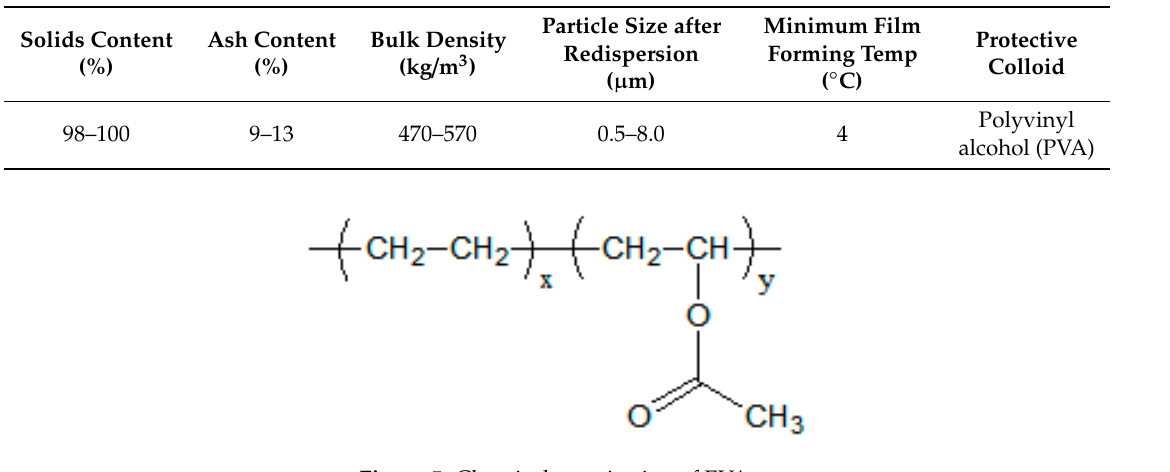
Figure 5. Chemical constitution of EVA.